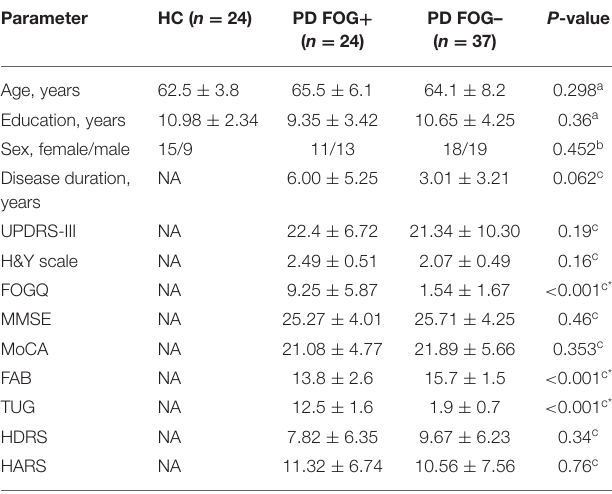
TABLE 1 | Demographic and clinical characteristics of